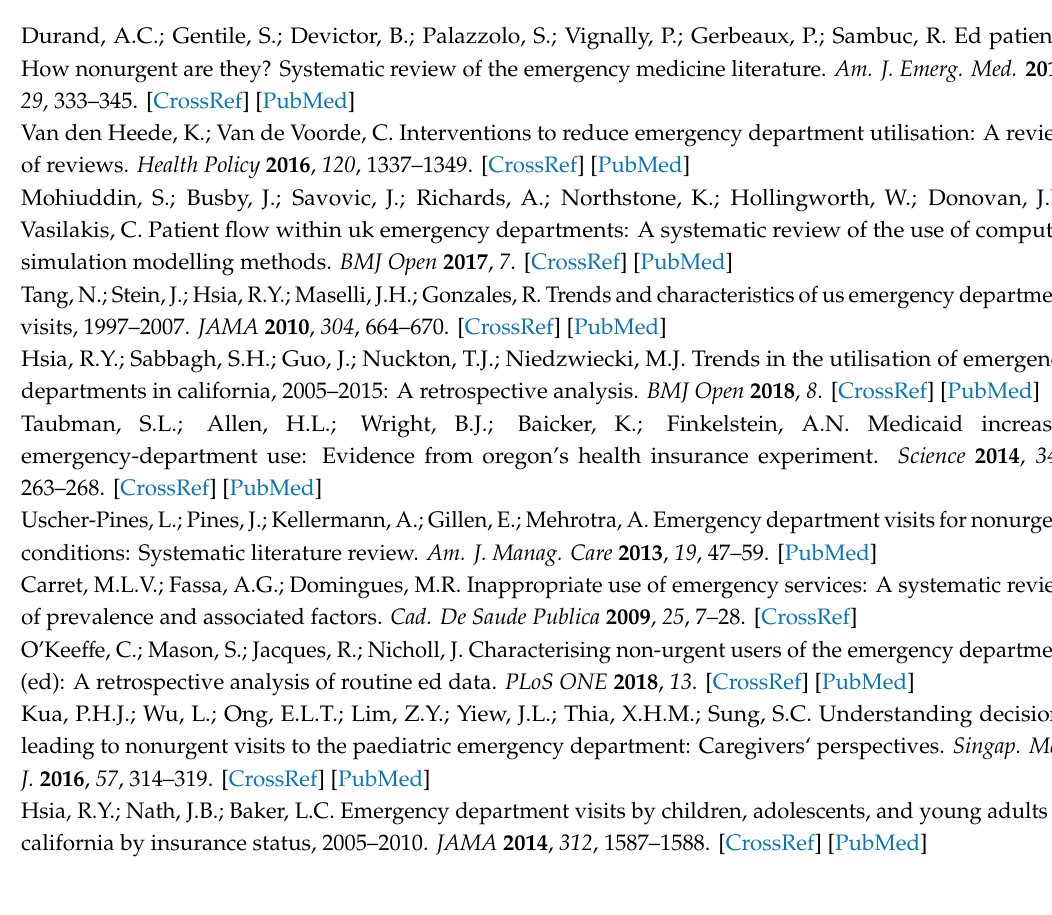
Table S1: Average marginal e ff ect (AME) by factors for non-emergent ED visits from three representative study cohorts (LHID2000, LHID2005, LHID2010) in Taiwan. ( n = 1,000,000 for each cohort, total ED visits, n =